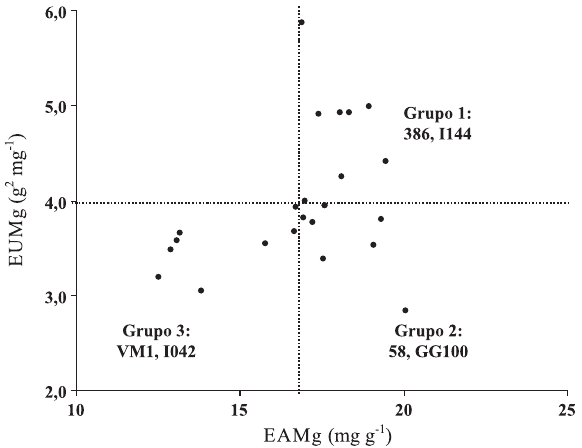
enxofre.Figura 6. Diagrama de distribuição dos clones de eucalipto em função das eficiências de absorção (EA) e de utilização (EU) de